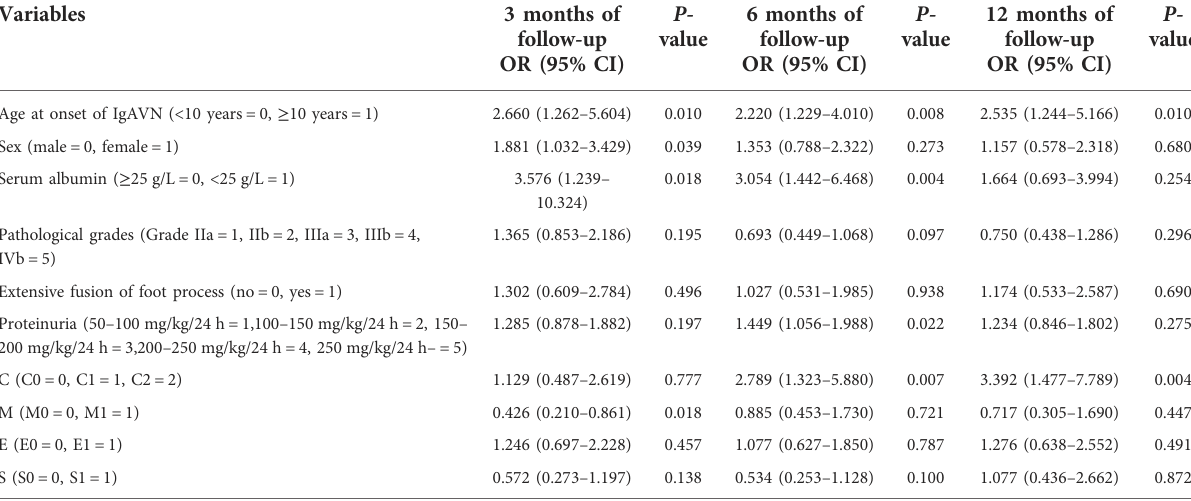
TABLE 4 Multivariate risk factor analysis for nonremission of proteinuria.